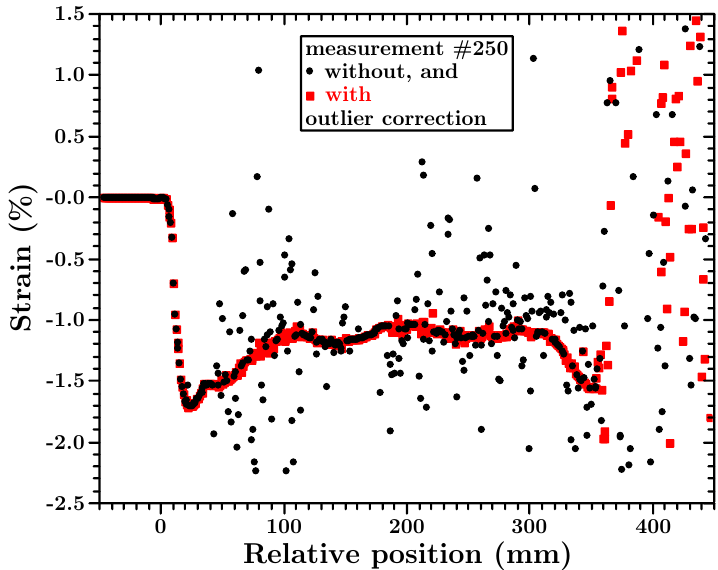
Figure 6. Absolute strain values for Measurement Number 250 (3032min). Black points/red squares: uncorrected/corrected for outliers in the preceding measurements (cf.